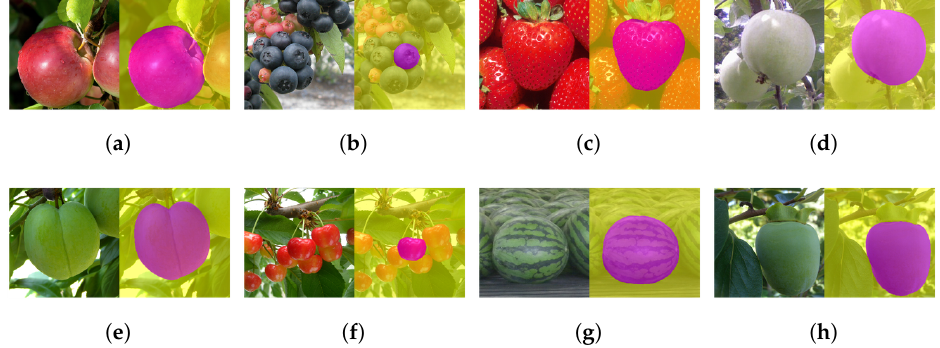
Figure 7. Examples ( a – h ), where peduncle and calyx are properly ignored. Some of the original photos are credited to USDA ARS; ( a ) to Peggy Greb, ( b ) to Mark Ehlenfeldt, ( c ) to Brian Prechtel. Moreover, the original photos of ( e – h ) are credited to Hideki